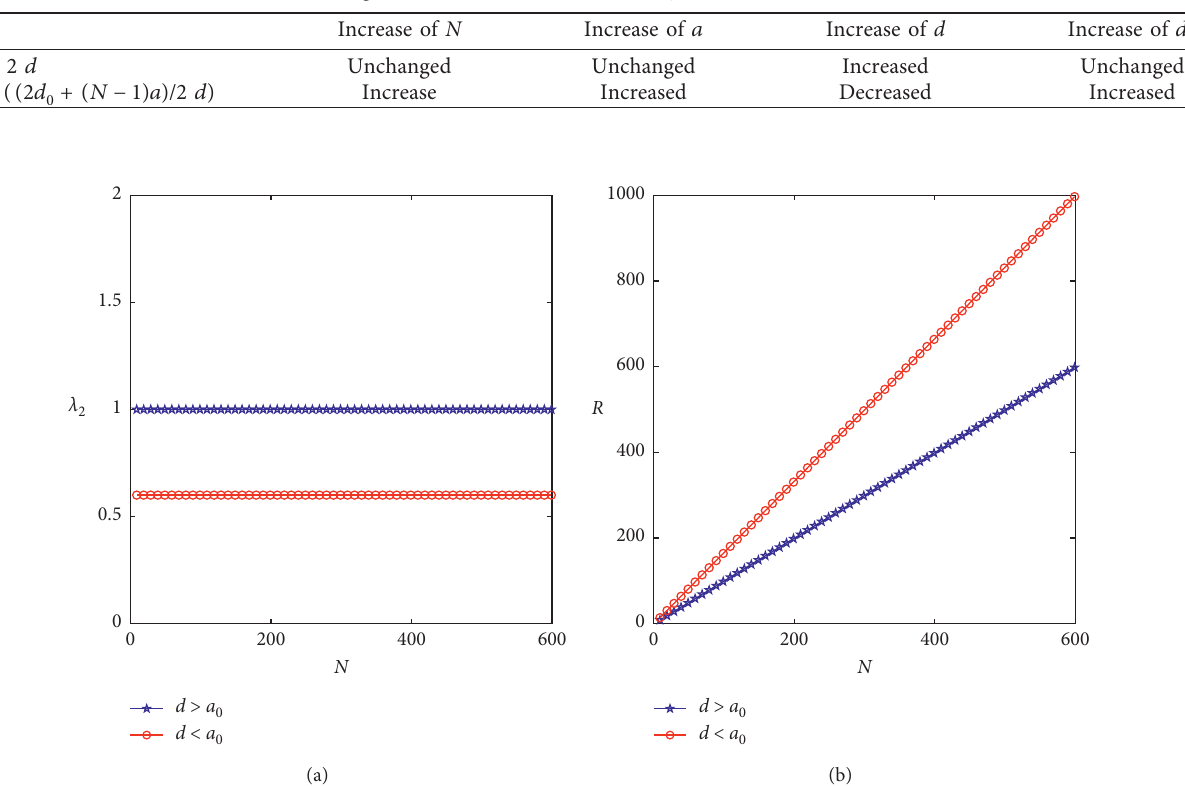
Figure 10: When N is odd, the synchronizability of Network II changes with the number of the subnetwork nodes N . (a) λ ( N changes from 9 to 599); (b) R changes with N ( N changes from 9 to